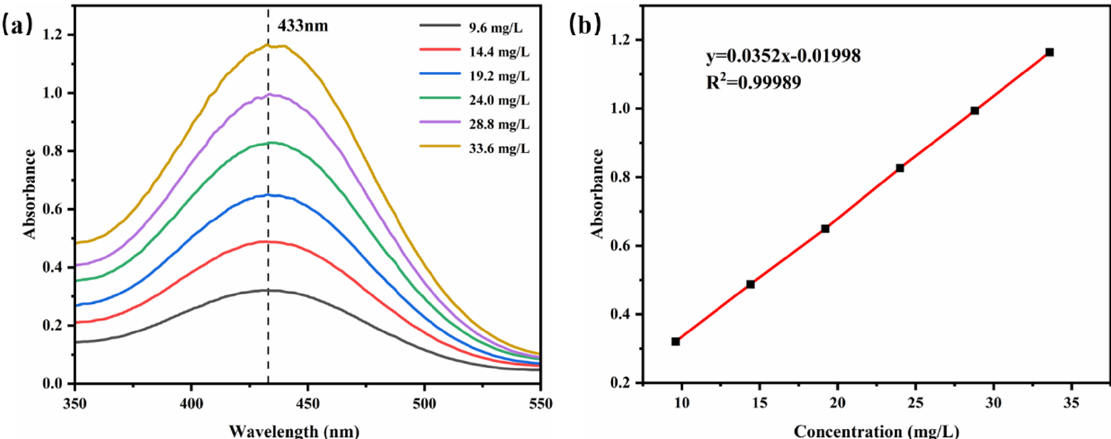
Figure 8. UV absorption spectra ( a ) and standard curve ( b ) of the TB-BCG-BCP-water standard solution.